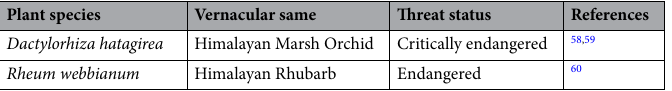
Table 2. Threat status of the plant species under study.